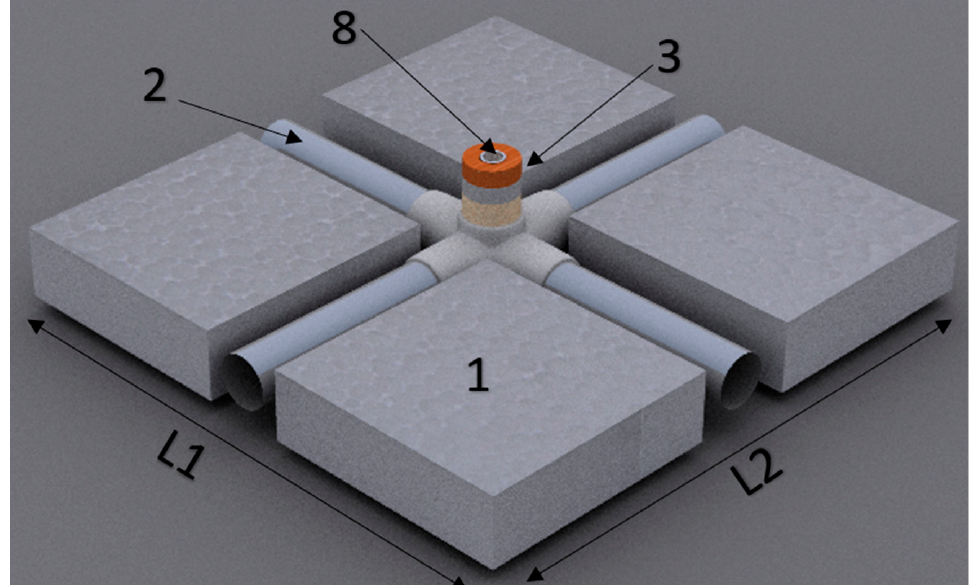
Figure 12. More details of the novel multipurpose self-irrigated GRs. (1) Polystyrene foam or other low-weight materials (the same diameter of PVC pipe); (2) PVC (75 mm, 90 mm, 100 mm, or 110 mm); (3) multilayer filter (the same diameter as the pipe and the exact height of the total green roof dimension); (8) drain filters; L1 and L2 indicate the width for installation of a filter that depends on the soil media and required filter for sub-irrigation.